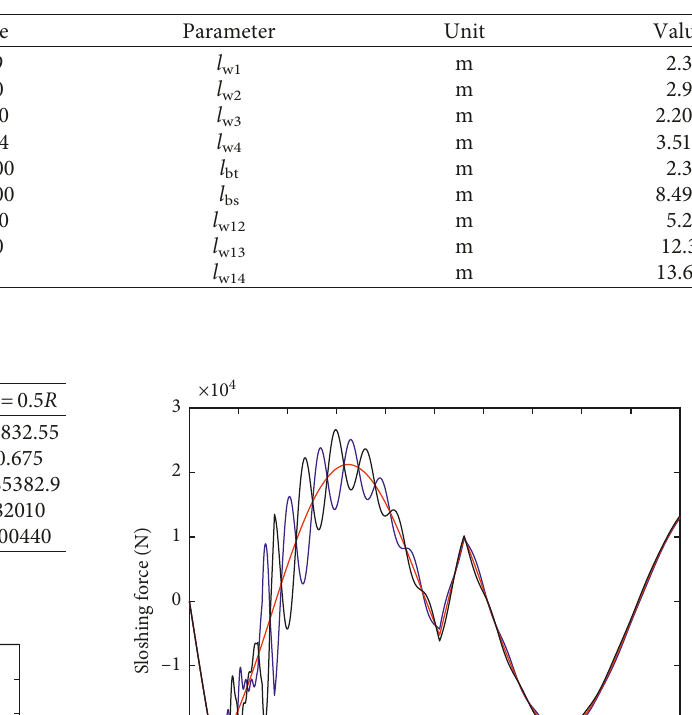
Table 3: Parameters of the vehicle model.